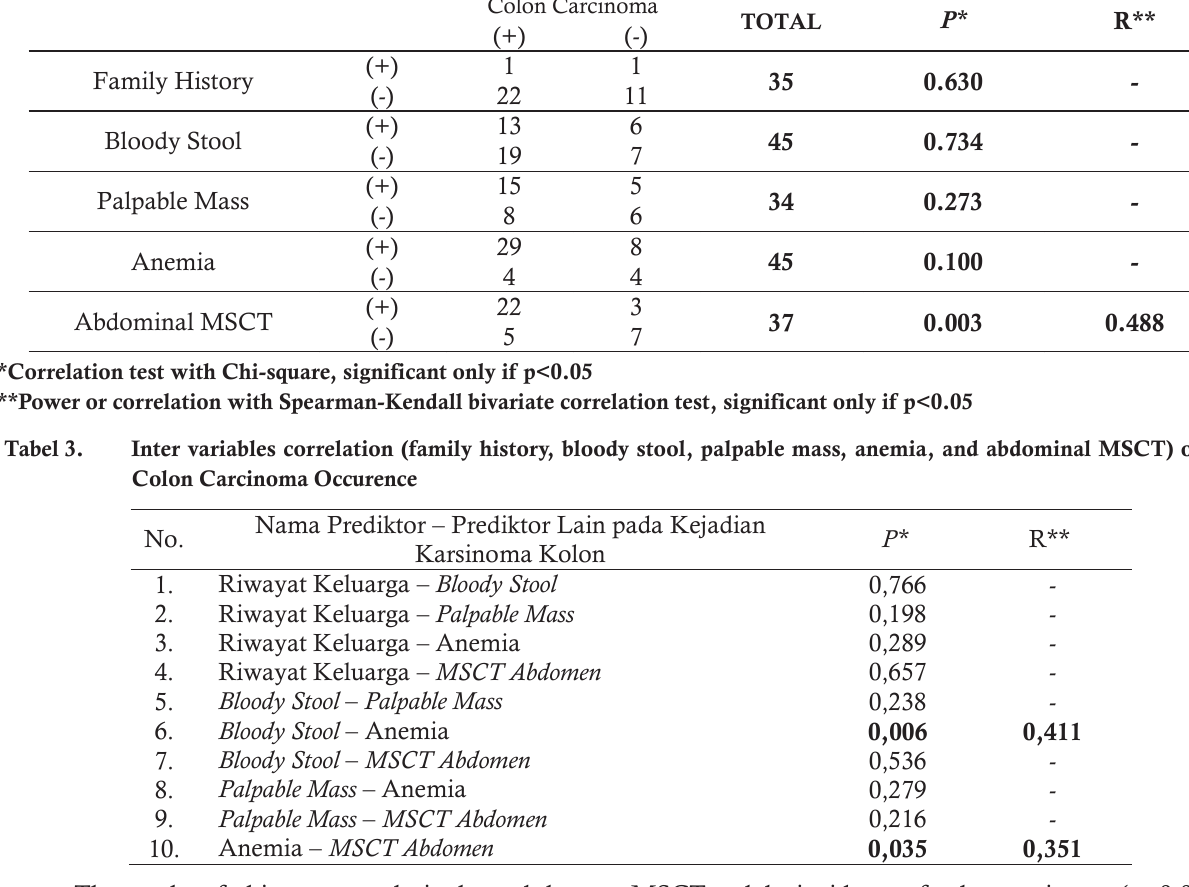
Table 2. Relationships between Variables (family history, bloody stool, palpable mass, anemia, and abdominal MSCT) with Occurrence of Colonic Carcinoma